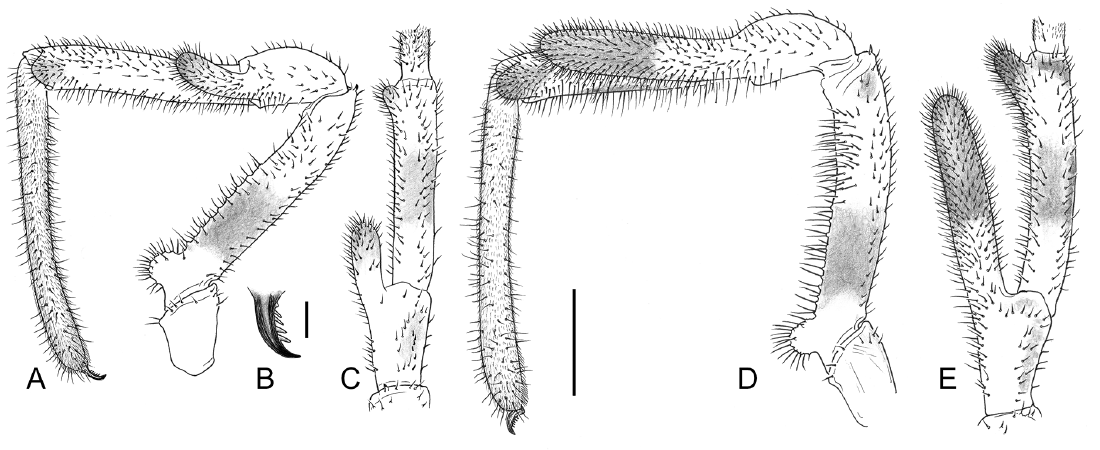
Fig. 14. Dicranopalpus gallaecicus sp. nov. Right pedipalp. A – C . Male (holotype, CHW 491). D – E . Female (paratype, CHW 492). A , D . Median view. B . Claw. C , E . Dorsal view of patella and tibia. Scale bars: A, C–E = 0.5 mm; B = 50 μm.